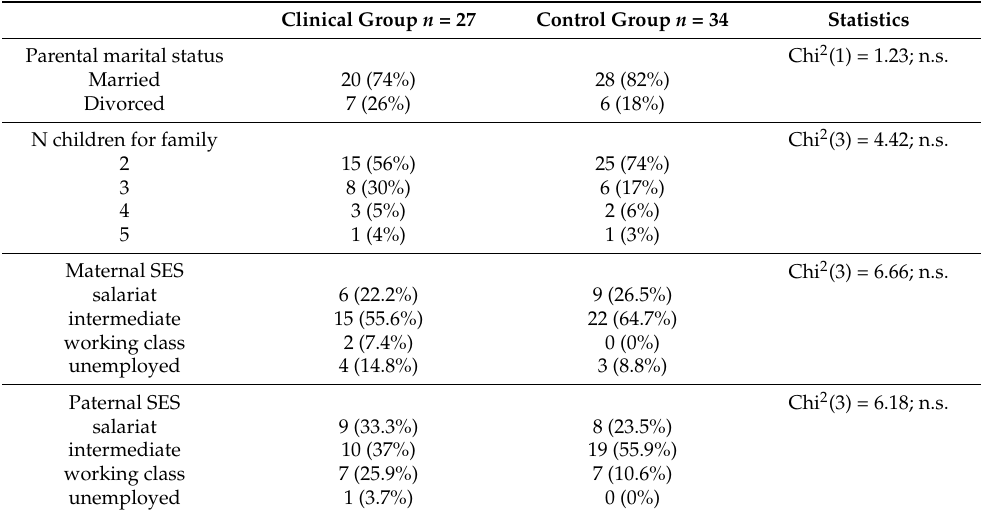
Table 1. Comparison between Clinical and control group families in socio-demographic